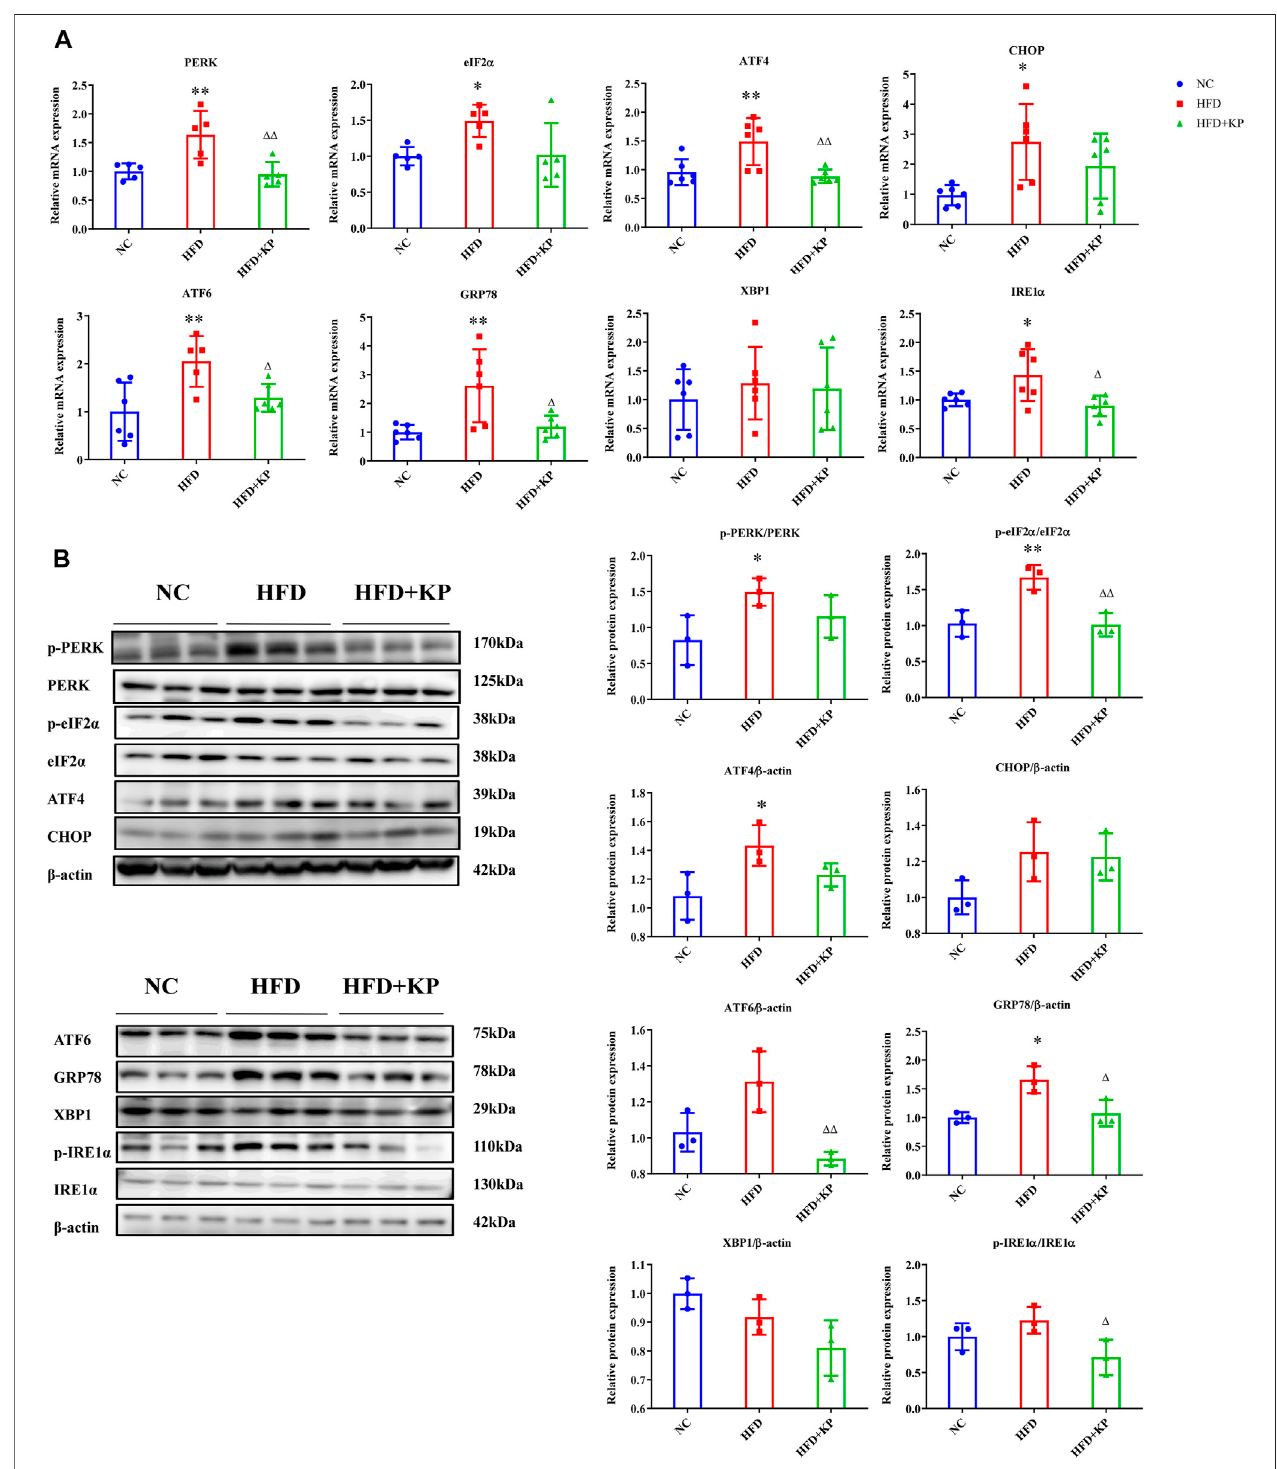
FIGURE 2| KP regulated themRNA and protein expression offactors related to ERS in vivo . (A) : mRNA expression in liver samples; (B) : protein expression inliver samples. NC: Normal control group, HFD: HFD group, HFD + KP: HFD + KP group. For (A,B) , Quanti fi cation of mRNA and protein level expression was normalized to β -actin levels, except protein phosphorylation level expression of PERK, eIF2 α , IRE1 α expression was normalized to their prototypes. Compared with group NC, *, p < 0.05, **, p < 0.01; Compared with group HFD, △ , p < 0.05, △△ , p < 0.01.